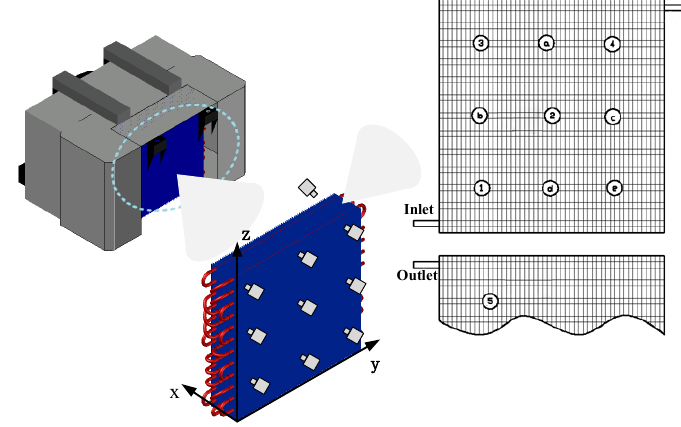
Figure 3. Schematic diagram of five experimental measuring points. For the air velocity measurement, the probe is placed on nine different measurement points on the inlet side. Moreover, the air velocity is converted into an electrical signal by the air velocity probe and, in this way, is displayed on the anemometer. Five points are selected to analyze the thickness of the frost layer marked as No. 1–5. The cameras are fixed at the edge of the air-cooler at 5 mm, and the fins and evaporation tubes at five measurement points are regularly photographed. The frost thickness is obtained by comparing the thickness between the fins and the evaporation tubes after frosting at different